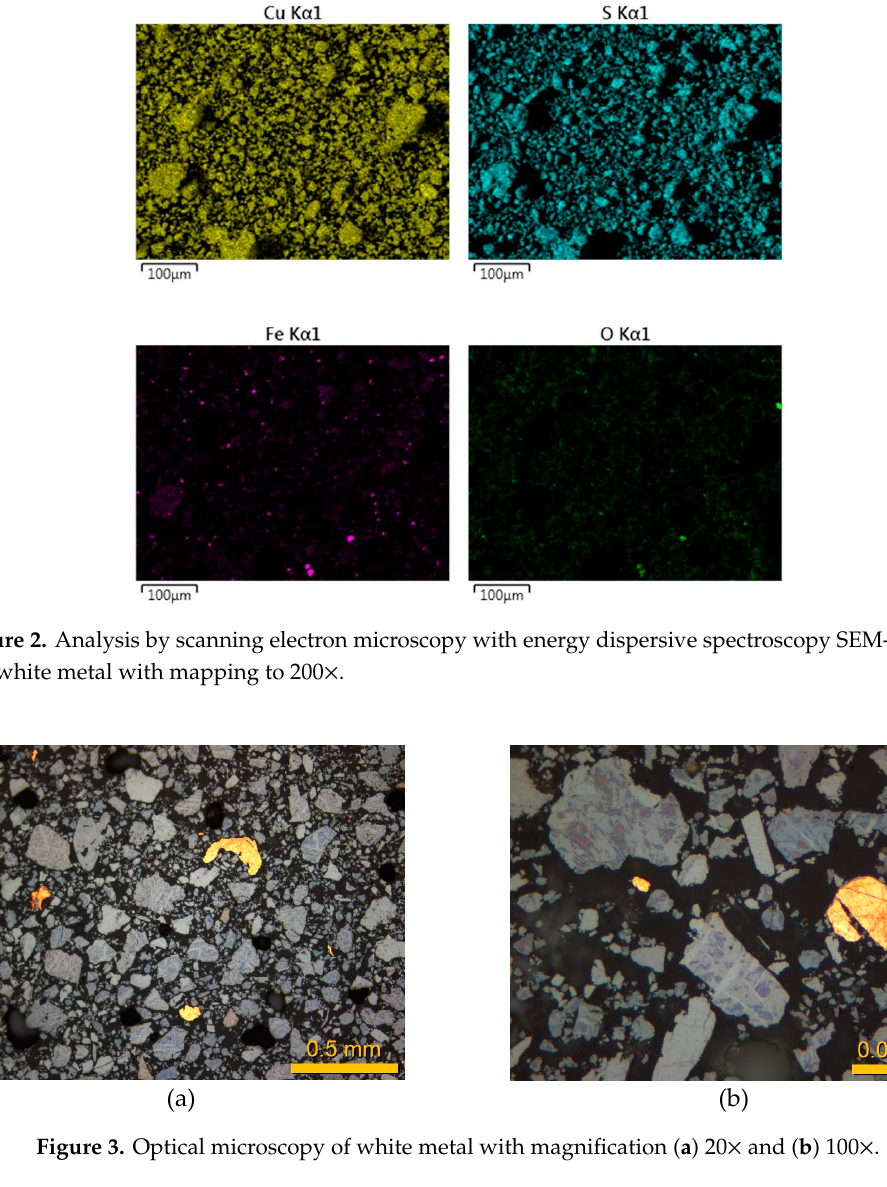
Figure 3. Optical microscopy of white metal with magnification ( a ) 20× and ( b ) 100×.